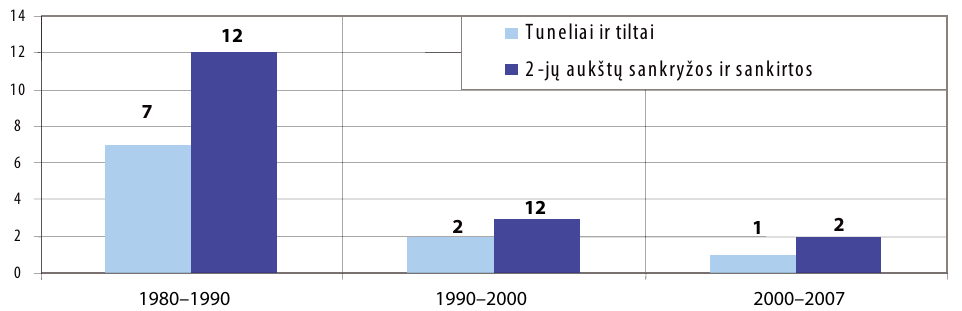
5 pav. Vilniaus susisiekimo infrastruktūros plėtra Fig. 5. Development of Vilnius transportation